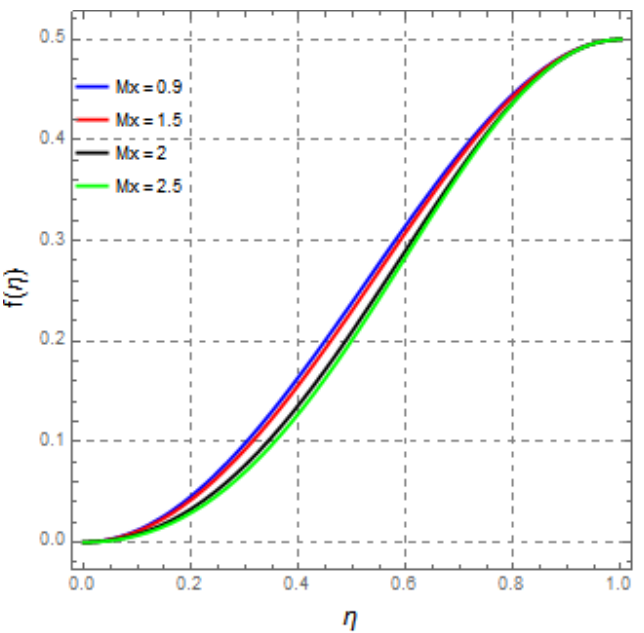
Figure 8. Impact of magnetic field strength M x on the velocity component f , keeping S z = − 2, M y = 3, R m = 1, and S =